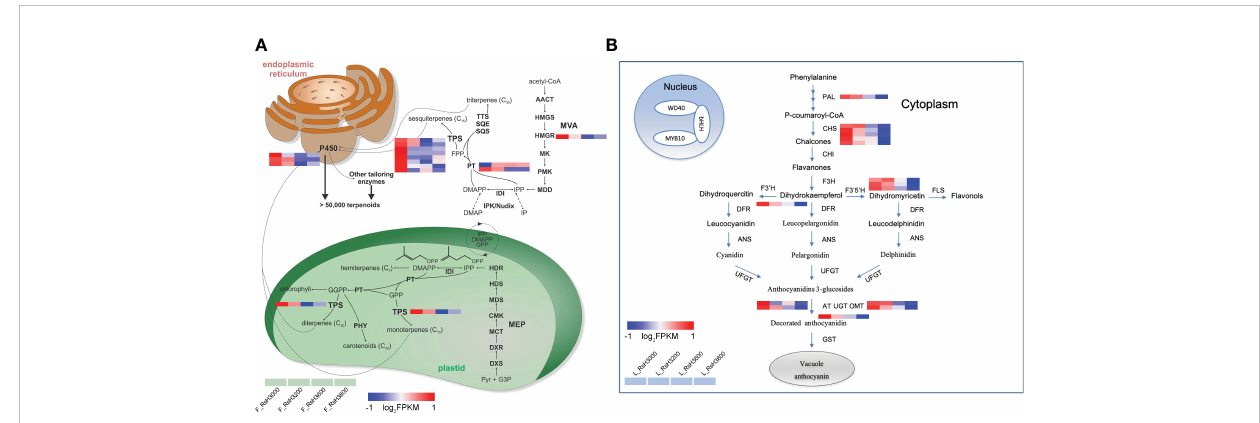
FIGURE 6 Schematic overview of major terpenoid (A) (modi fi ed from Karunanithi and Zerbe, 2019) and fl avonoid (B) biosynthetic pathway identi fi ed in the organ of late fl ower buds and early leaf buds, respectively. Altitudes (here RsH3000-RsH3800, from left to right in each heatmap panel) are indicated in the legend. Gene expression pro fi le (in normalized FPKMs) at different elevations are presented in a heatmap alongside the gene names. The bar represents the expression level of each gene. Low to high expression is indicated by a change in color from blue to red, respectively.